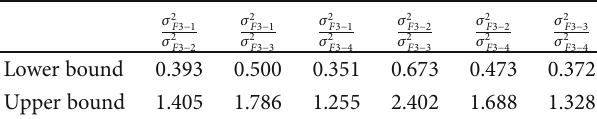
Table 8, we know n 1 = 18 , S 2 F3 − 1 = 1 : 138 , n 2 = 18 , S 2 F3 − 1 =